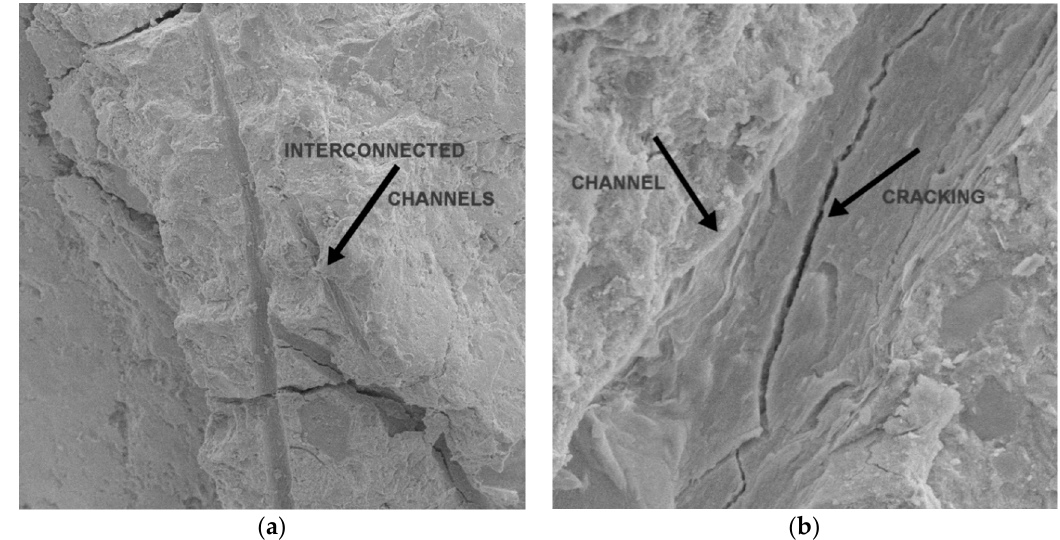
Figure 10. Formation of channels and cracking in the concrete matrix of CPP3 sample: ( a ) 400X; ( b ) 3000X.